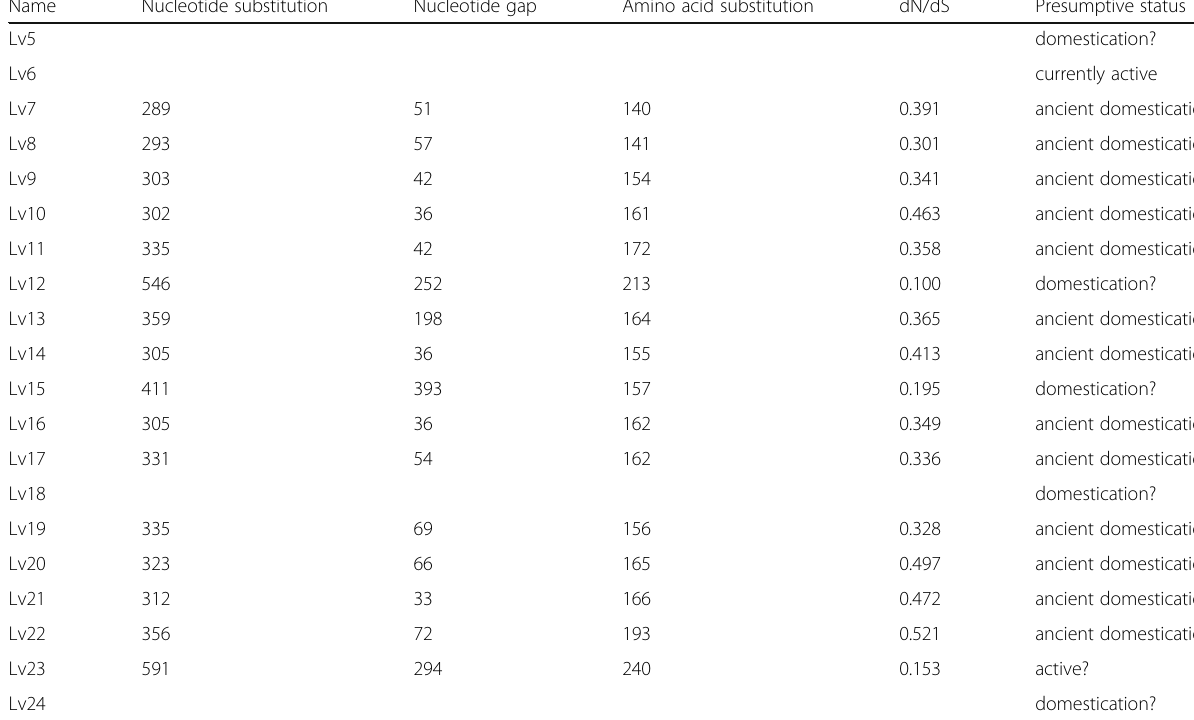
Table 4 Differences in transposase CDSs and amino acids, and presumptive status (Continued)